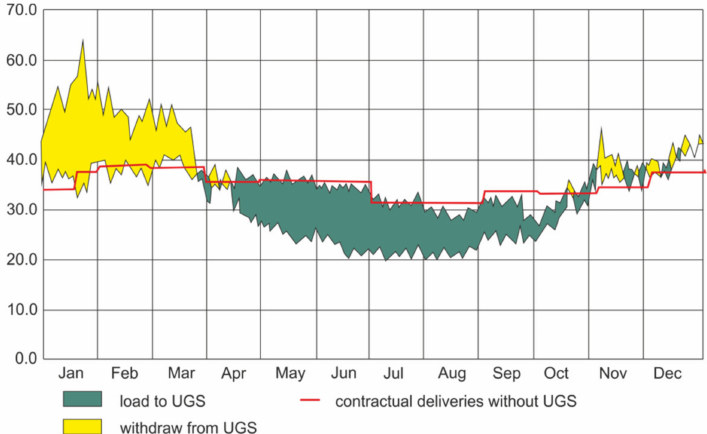
Figure 1. The course of demand and supply of high-methane natural gas in 2006; (UGS, underground gas storage) [3]. Table 1. The number and types of underground gas storage facilities (fields) located in selected European countries (source: own study based on [2]). Country Underground Gas Storage (UGS) Facilities in Salt